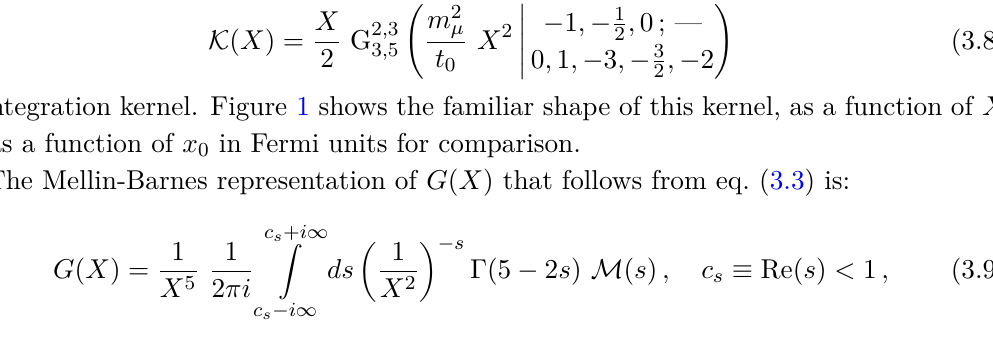
and as a function of x